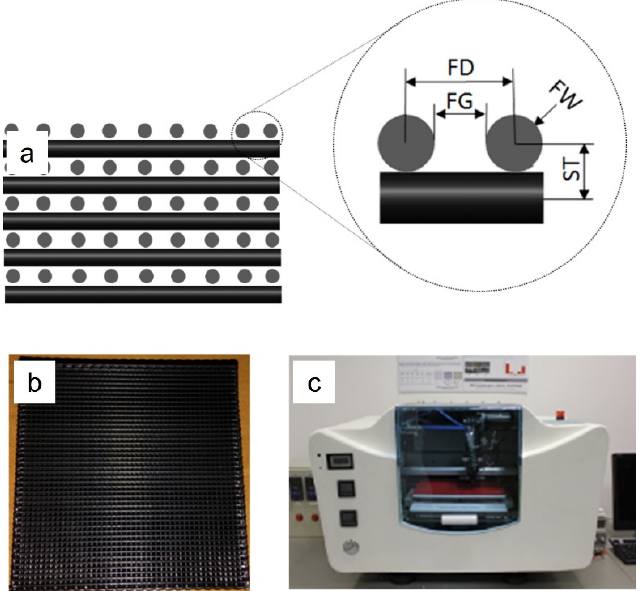
Figure 1. Scaffold design and fabrication; ( a ) cross-section of a 3D PCL/GPN design and its design parameters (FG, FD, FW, and ST); ( b ) 3D PCL/GPN scaffold, fabricated using the ( c ) Bioextruder ® system (CDRSP homemade extrusion-based AM system). Table 1. D scaffold design and AM extrusion-based processing parameters.